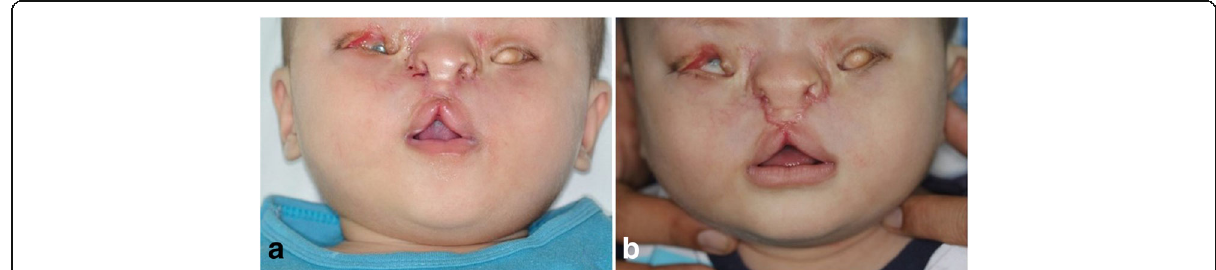
Fig. 4 Postoperative follow-up photographs. a At suture removal. b 3 months after the